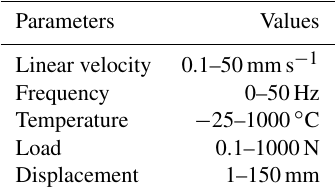
Table 2. The evaluation parameters of the coefficients of friction (COFs) under different